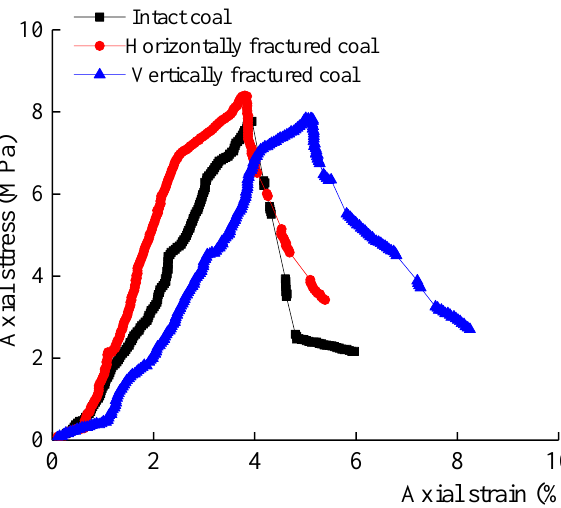
Figure 13. Stress–strain curve of the coal specimens.